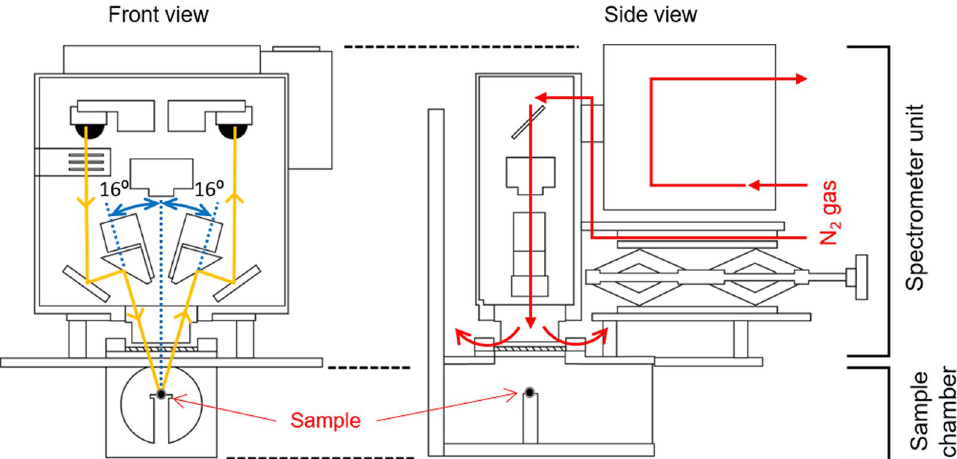
Fig. 1 Overview of the FTIR measurement system with front and side views of the spectrometer unit and the sample chamber. Yellow and red lines are the light path of the incident beam and nitrogen gas flow,